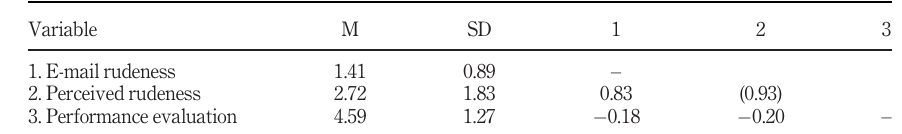
Table 3. Means, standard deviations and correlations among Study 2 variables